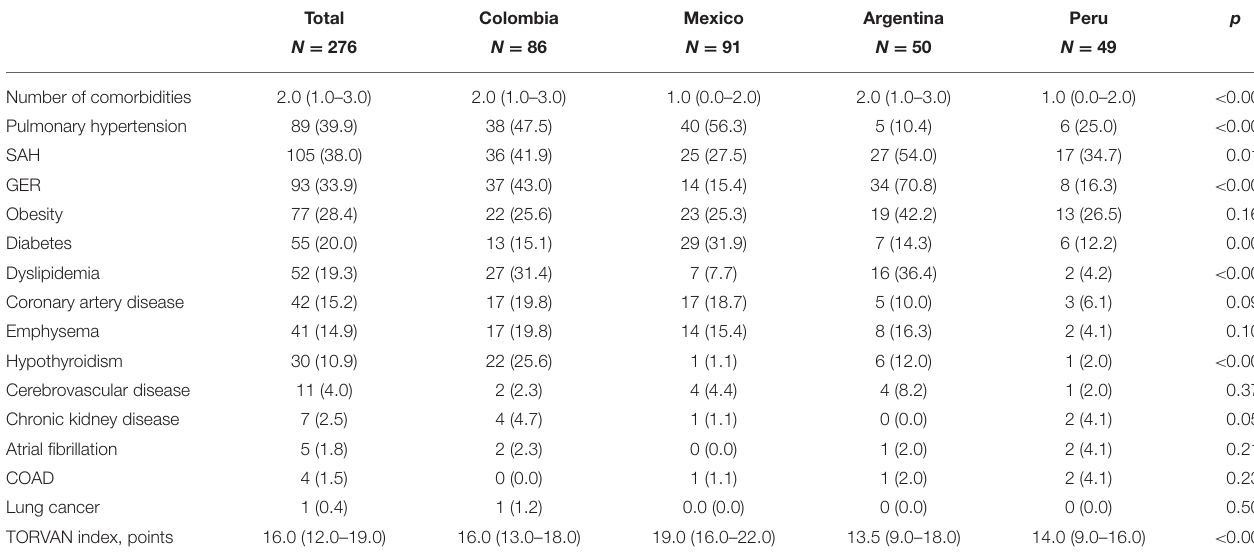
TABLE 2 | Comorbidities by